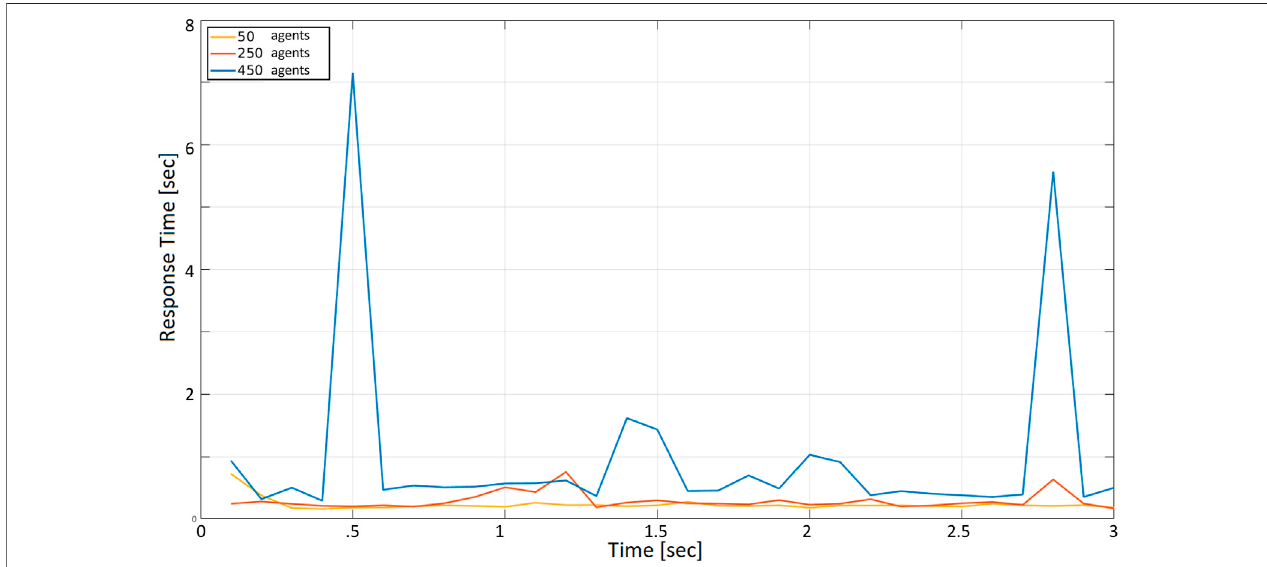
FIGURE 9 | Cloud response time with a request period r = 0.1 s with 50, 250, and 450 agents.